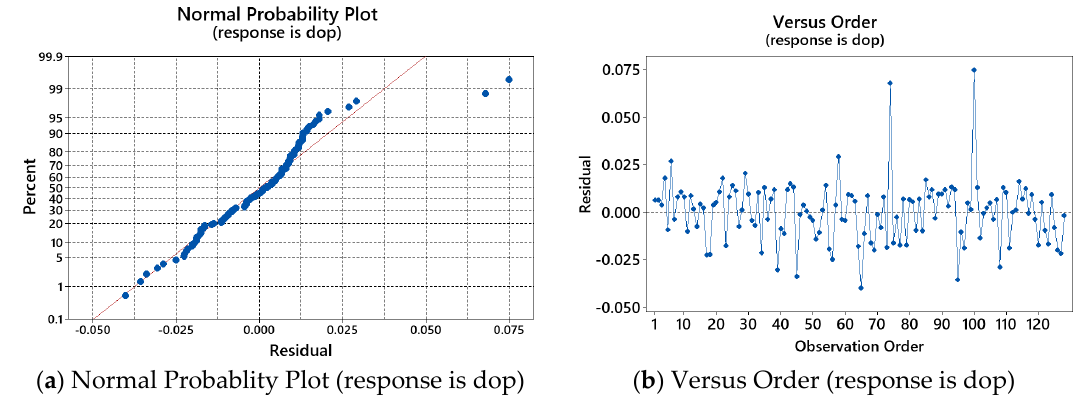
Figure 11. Normal probability and versus order plot for d op .